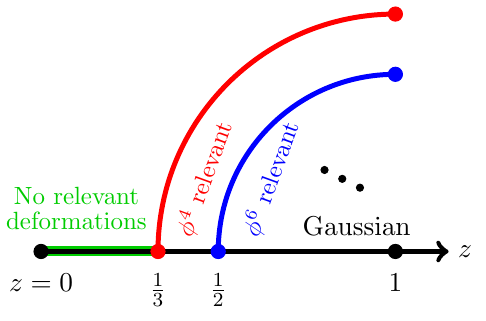
Figure 1. Conjectured pattern of critical points of